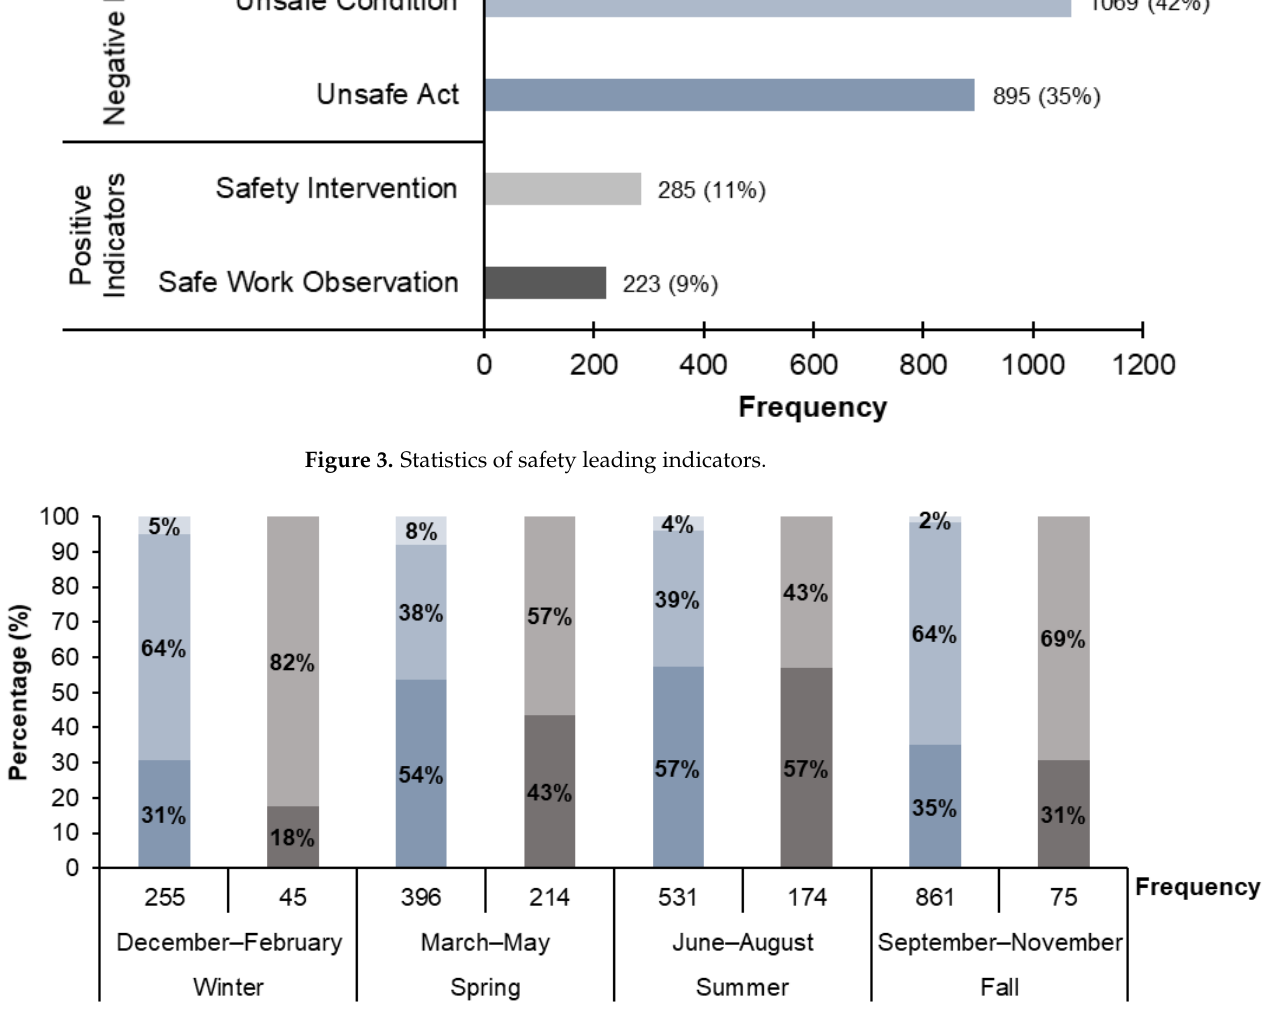
Figure 4. Statistics of safety leading indicators.